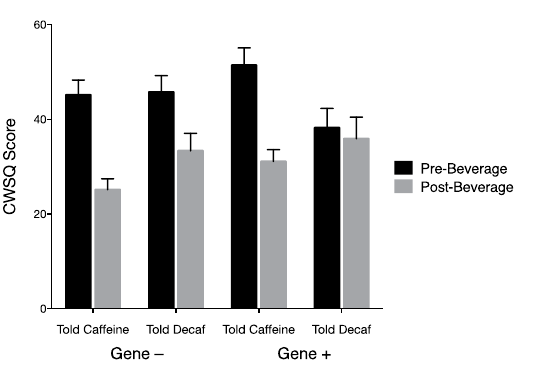
Figure 2. Effect of Time, Priming, and Caffeine Information on Caffeine Withdrawal Symptoms. Error bars indicate standard